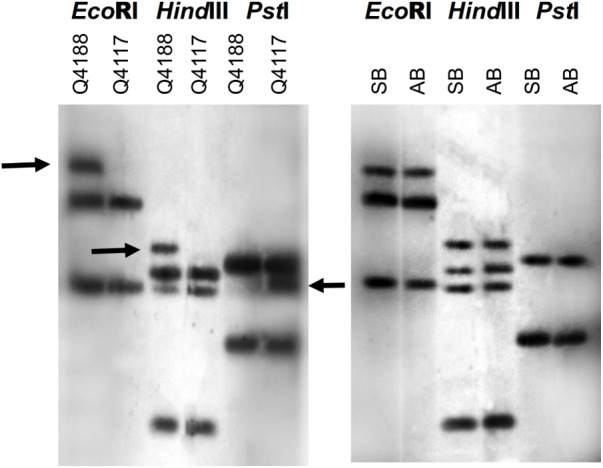
Bulked segregant analysis of the QGJ locus on the P. notatum genome. Three different restriction enzymes (EcoRI, HindIII, and PstI) were used to digest the genomic DNA samples. The complete original N46 fragment was used as a probe. Left panel: Polymorphisms (marked with arrows) were detected between Q4188 (sexual genotype, mapping population female parent) and Q4117 (apomictic genotype, mapping population male parent). Right panel: Linkage analysis was performed by bulking genomic DNA extracted from 10 sexual (SB) and 10 apomictic (AB) F1 individuals obtained from crossing Q4188 (female) and Q4117 (male).